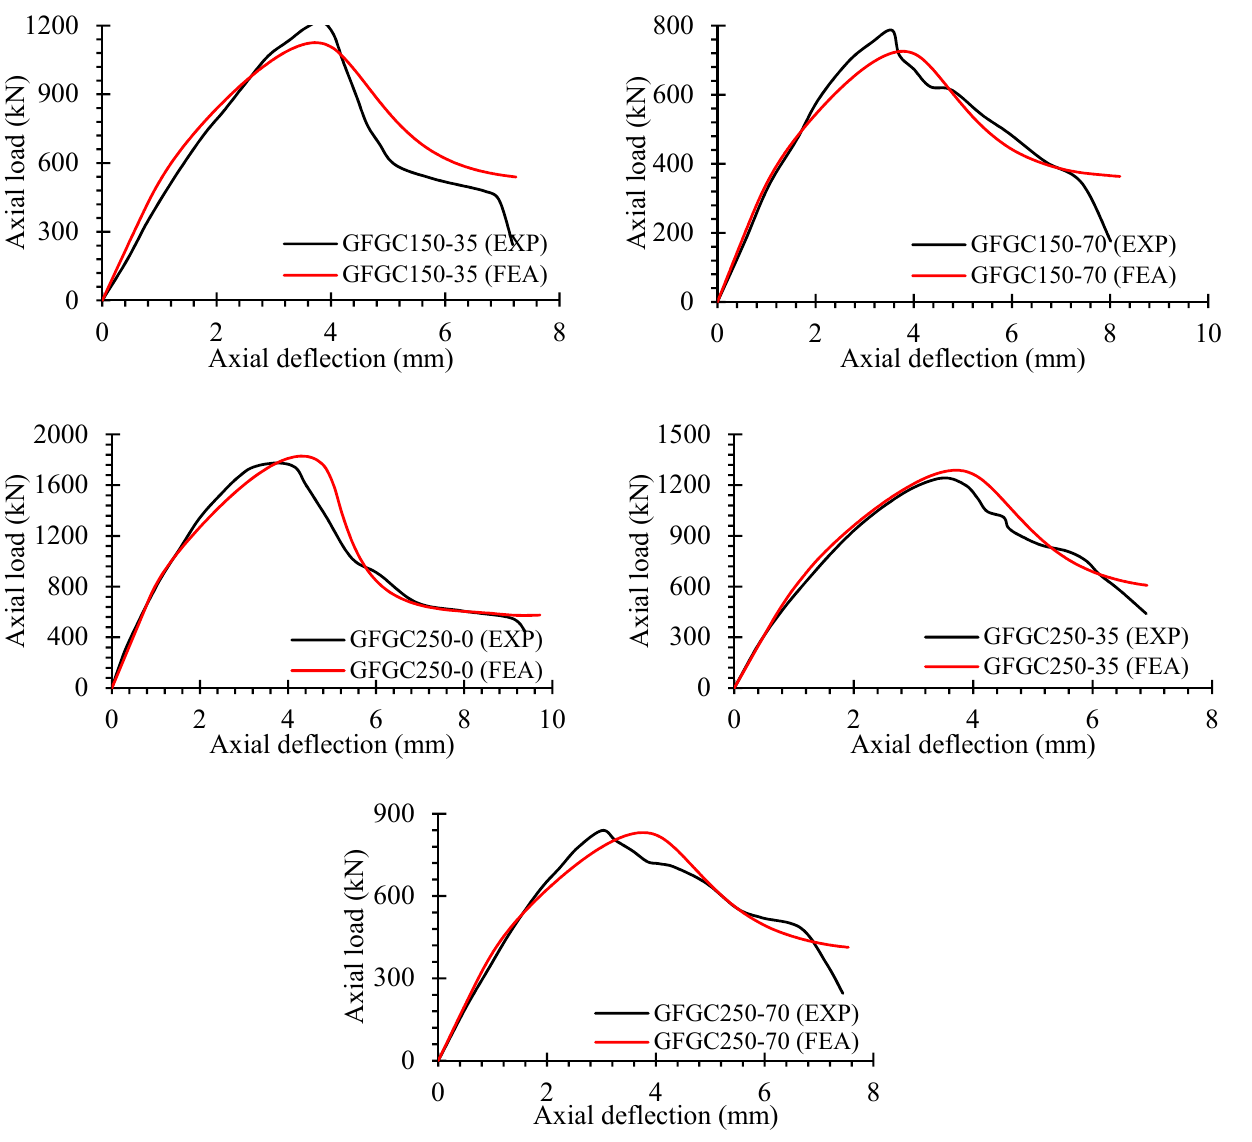
Figure 14. Comparison of experiments and FEA measurements for load-deflection curves of GFGC samples.